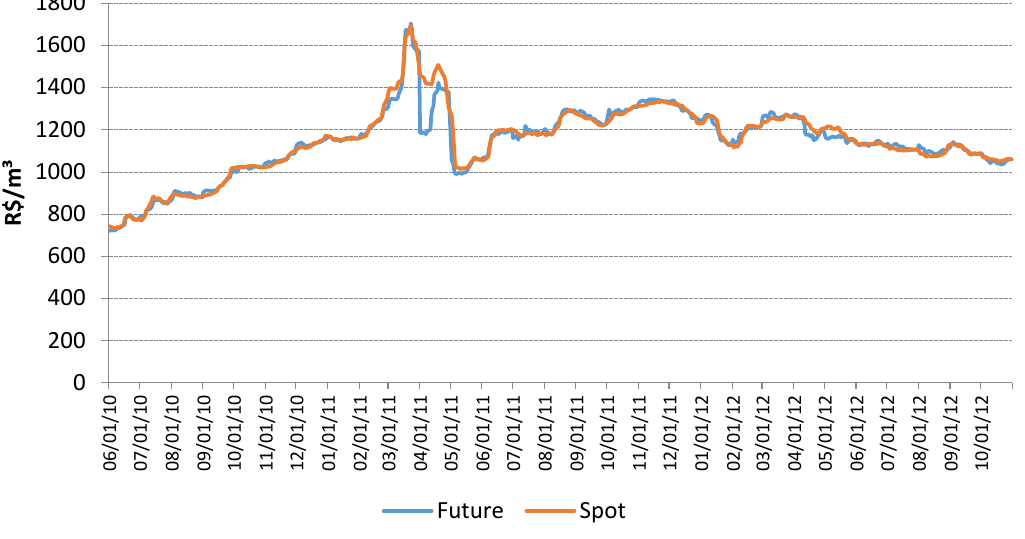
Figure 2. Evolution of ethanol futures and spot prices in Brazil.